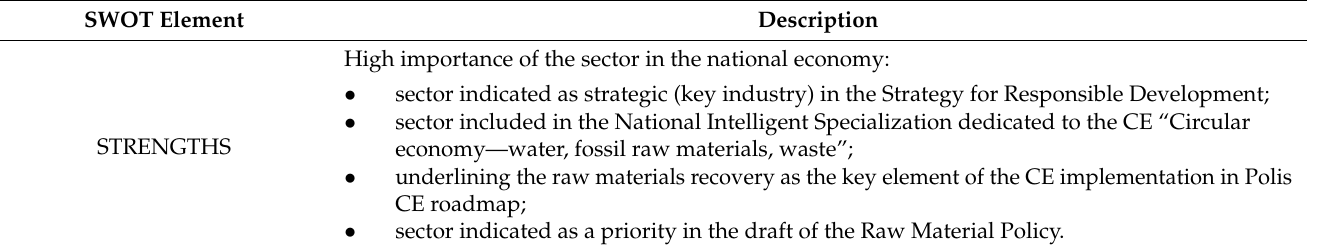
Table 2. SWOT analysis of the raw materials recovery sector in